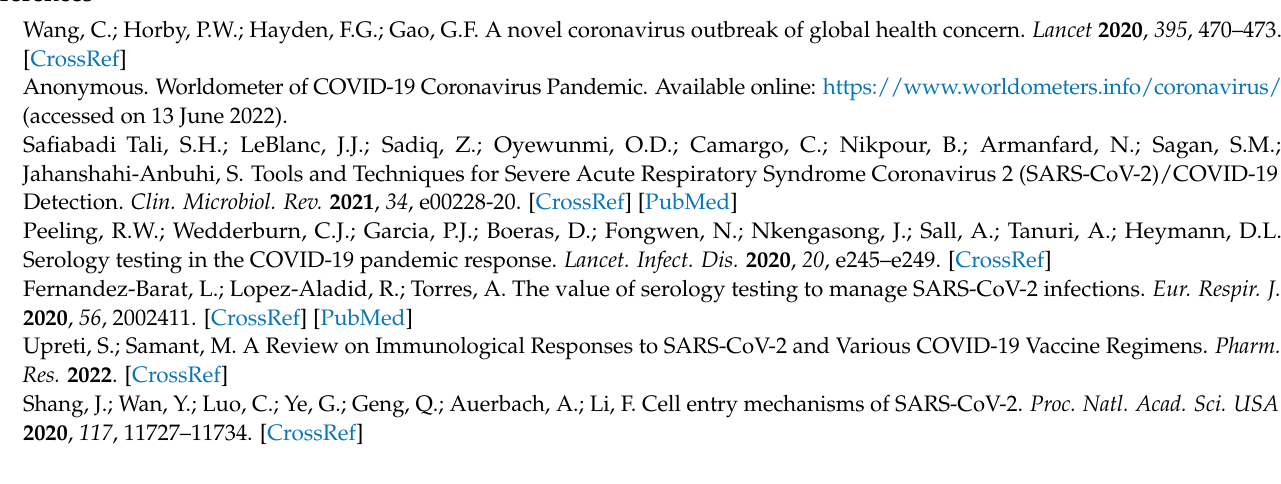
N proteins. Figure S2: Comparison of amino acid sequences of recombinant N proteins based on the results of mass spectrometric study. Figure S3: Mass spectrometry analysis of N protein (B.1). Figure S4: Mass spectrometry analysis of N protein (B.1.351). Figure S5: Mass spectrometry analysis of N protein (P.1). Figure S6: Mass spectrometry analysis of N protein (B.1.617.2). Figure S7: Mass spectrometry analysis of N protein (B.1.1.529). Figure S8: Mass spectrometry analysis of N protein (HCoV OC43). Table S1: Demographic characteristics of the study subjects. Table S2: Detected ions (MH+) and matched peptides from the recombinant N protein (B.1) according to peptide mapping. Table S3: Detected ions (MH+) and matched peptides from the recombinant N protein (B.1.351) according to peptide mapping. Table S4: Detected ions (MH+) and matched peptides from the recombinant N protein (P.1) according to peptide mapping. Table S5: Detected ions (MH+) and matched peptides from the recombinant N protein (B.1.617.2) according to peptide mapping. Table S6: Detected ions (MH+) and matched peptides from the recombinant N protein (B.1.1.529) according to peptide mapping. Table S7: Detected ions (MH+) and matched peptides from the recombinant N protein (HCoV OC43) according to peptide mapping. Reference [20] are cited in the supplementary